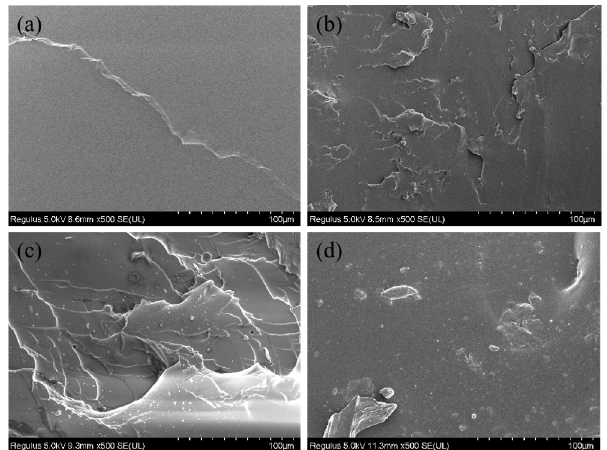
Figure 7. SEM images of the pure HTPB ( a ), GH ( b ), TGH ( c ) and GAH ( d ) liner sections